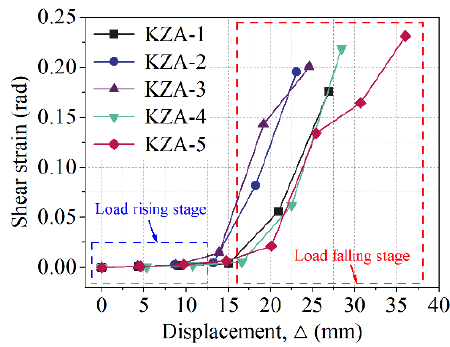
Figure 13. Shear deformation at the plastic hinge region.